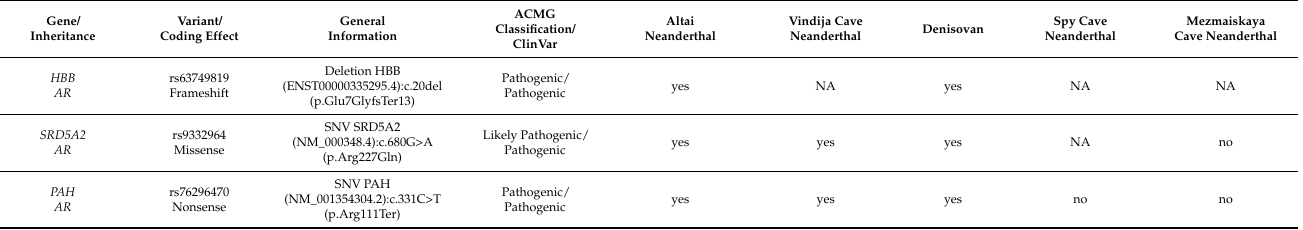
Table 2. Pathogenic mutations established in homozygous state in archaic human genome-wide